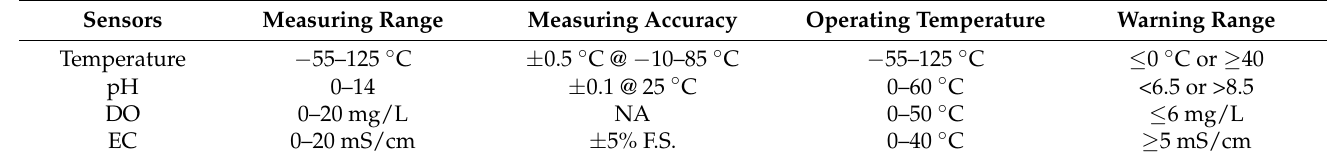
Table 3. Main specification and warning range of aquatic